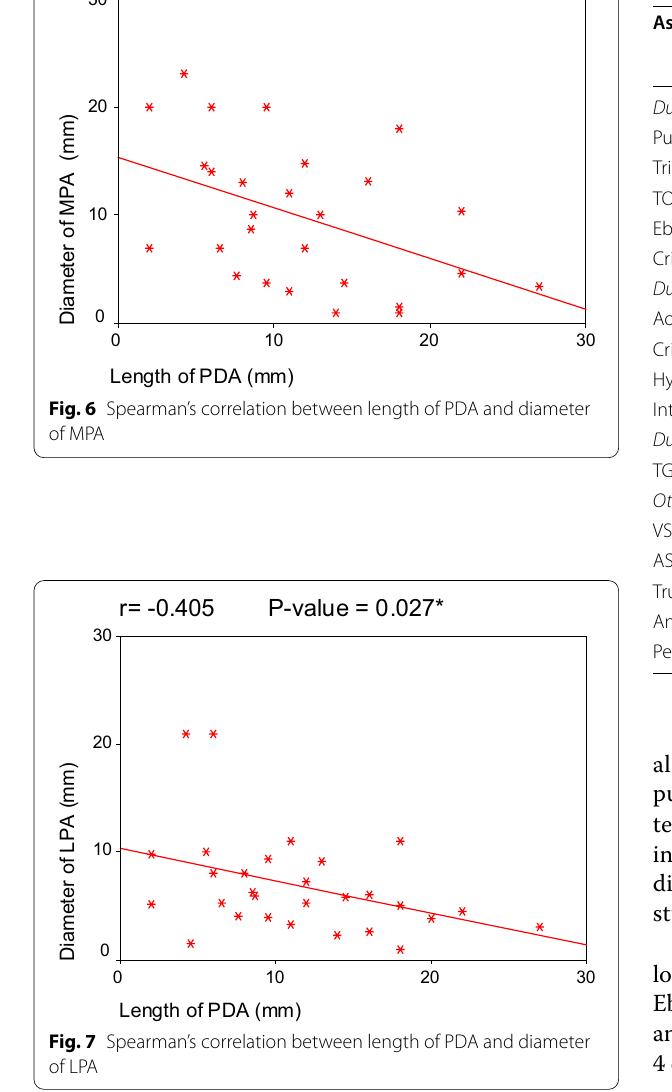
Table 3 Associated cardiac and extra cardiac anomalies with PDA in the studied patients ( n =